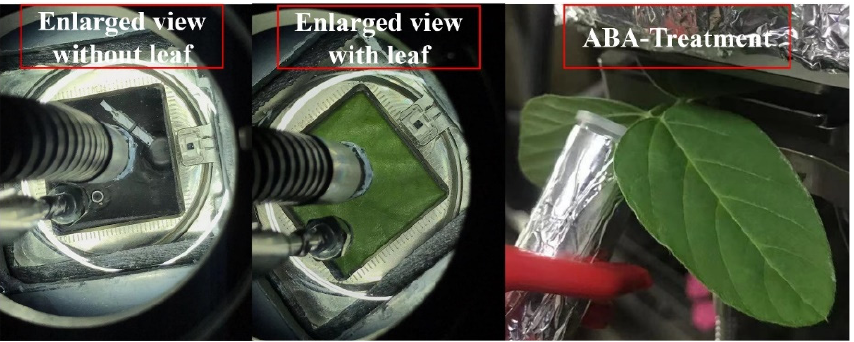
Figure 2. Enlarged views of the leaf chamber and abscisic acid (ABA) treatment with a microcen- trifuge tube.